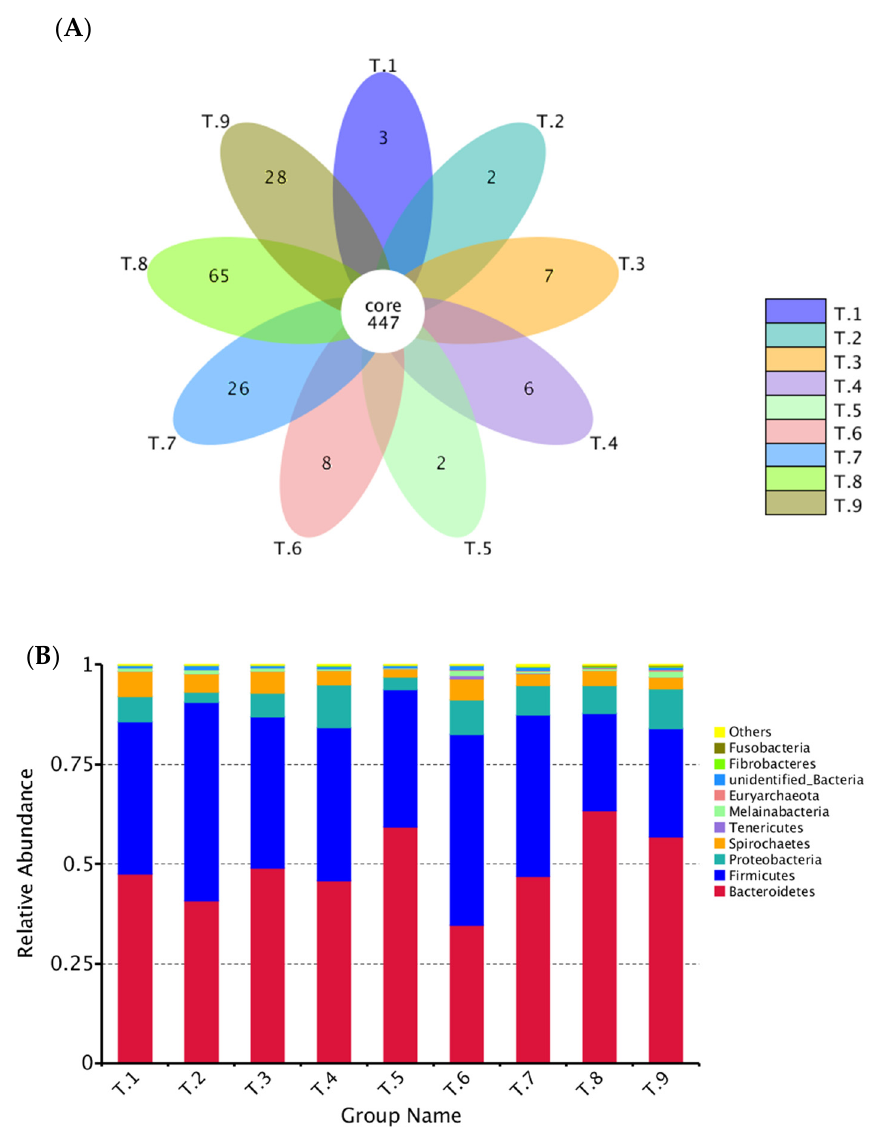
Figure 1. The bacterial OTU community composition and microbial diversity at the phylum level in colonic digesta of weaned piglets. ( A ) Flower diagrams for bacterial OTU in nine dietary treatments. ( B ) Microbial community bar-plot of the top 10 at the phylum level.